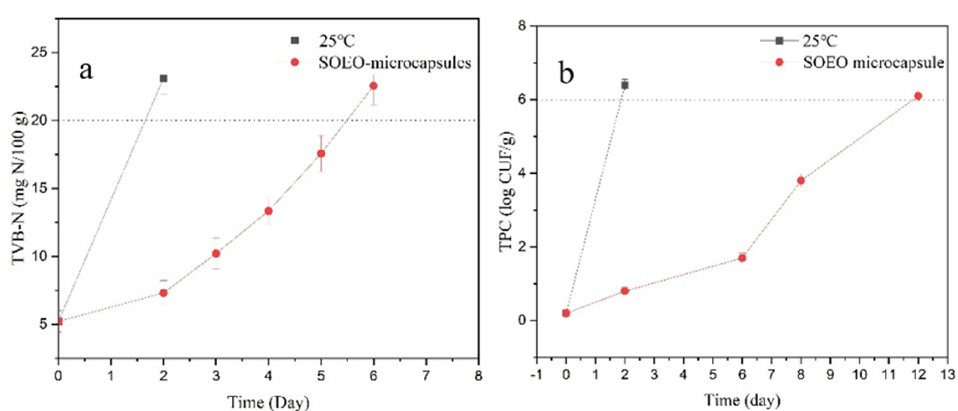
Figure 7. The TVB-N ( a ) and TPC ( b ) of crawfish under 25 °C and SOEO microcapsules.